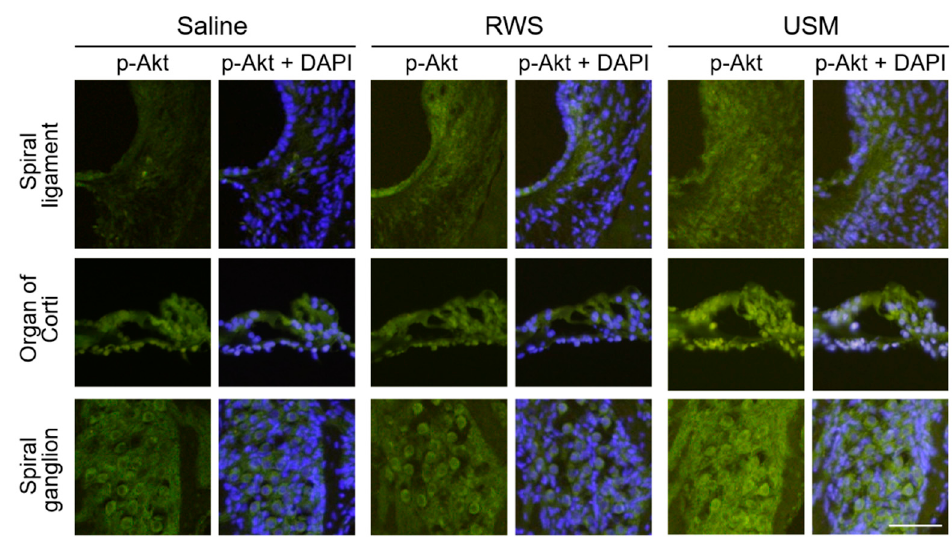
Figure 6. Immunohistochemical staining for p-AKT in a cryosection of the cochlea after noise exposure and different treatments. The combination of ultrasound microbubbles and IGF-1 (USM group), IGF-1 only (RWS group) or saline only (saline group) was administered 24 h after noise exposure. The samples were collected 2 h after treatment. Immunofluorescence staining showing p-AKT immunostaining (green) and nuclei (blue, DAPI). This experiment was repeated four times. Scale bars = 100 µm. IGF-1, insulin-like growth factor-1; DAPI = 4,6-diamidino-2-phenylindole; USM, ultrasound microbubble; RWS, round window soaking.